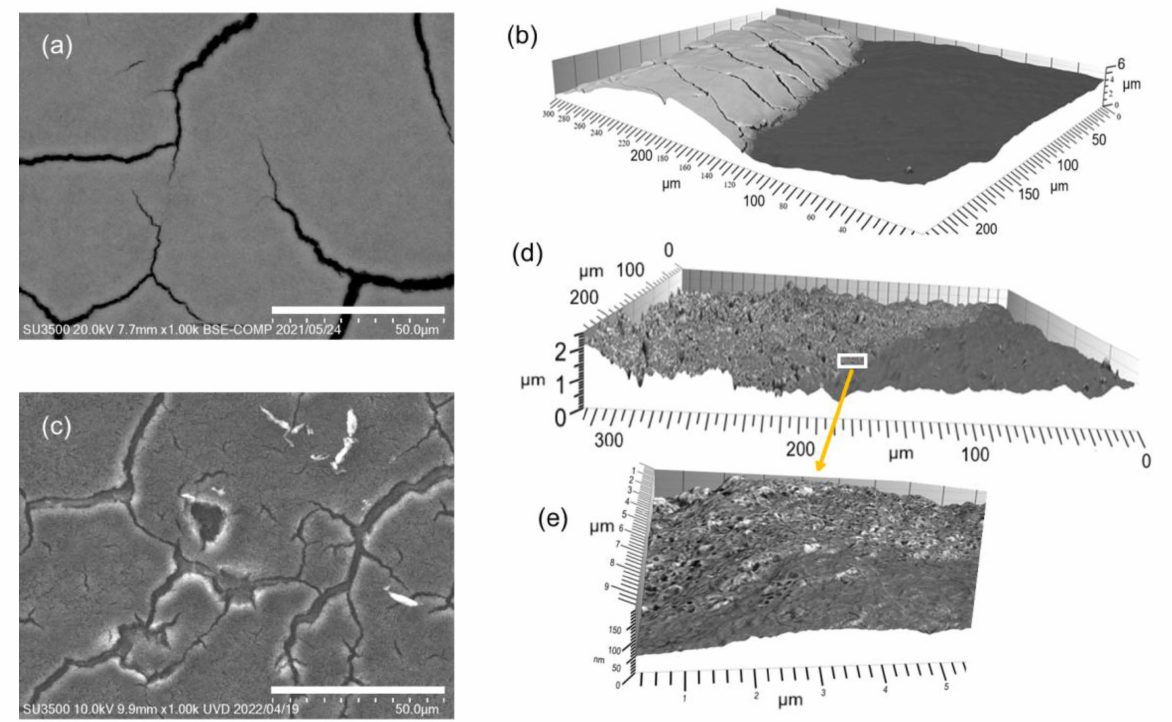
Figure 3. ( a ) SEM image of the SrZnSiP coating after laser irradiation. Magnification 1 × K, and ( b ) 3D image of the coating edge. ( c ) SEM image of the acid-leached coating surface. Magnification 1 × K, ( d ) 3D image of the acid-leached coating edge viewed diagonally from above. Magnification 10 × K, and ( e ) enlarged view of the coating edge. Magnification 30 ×